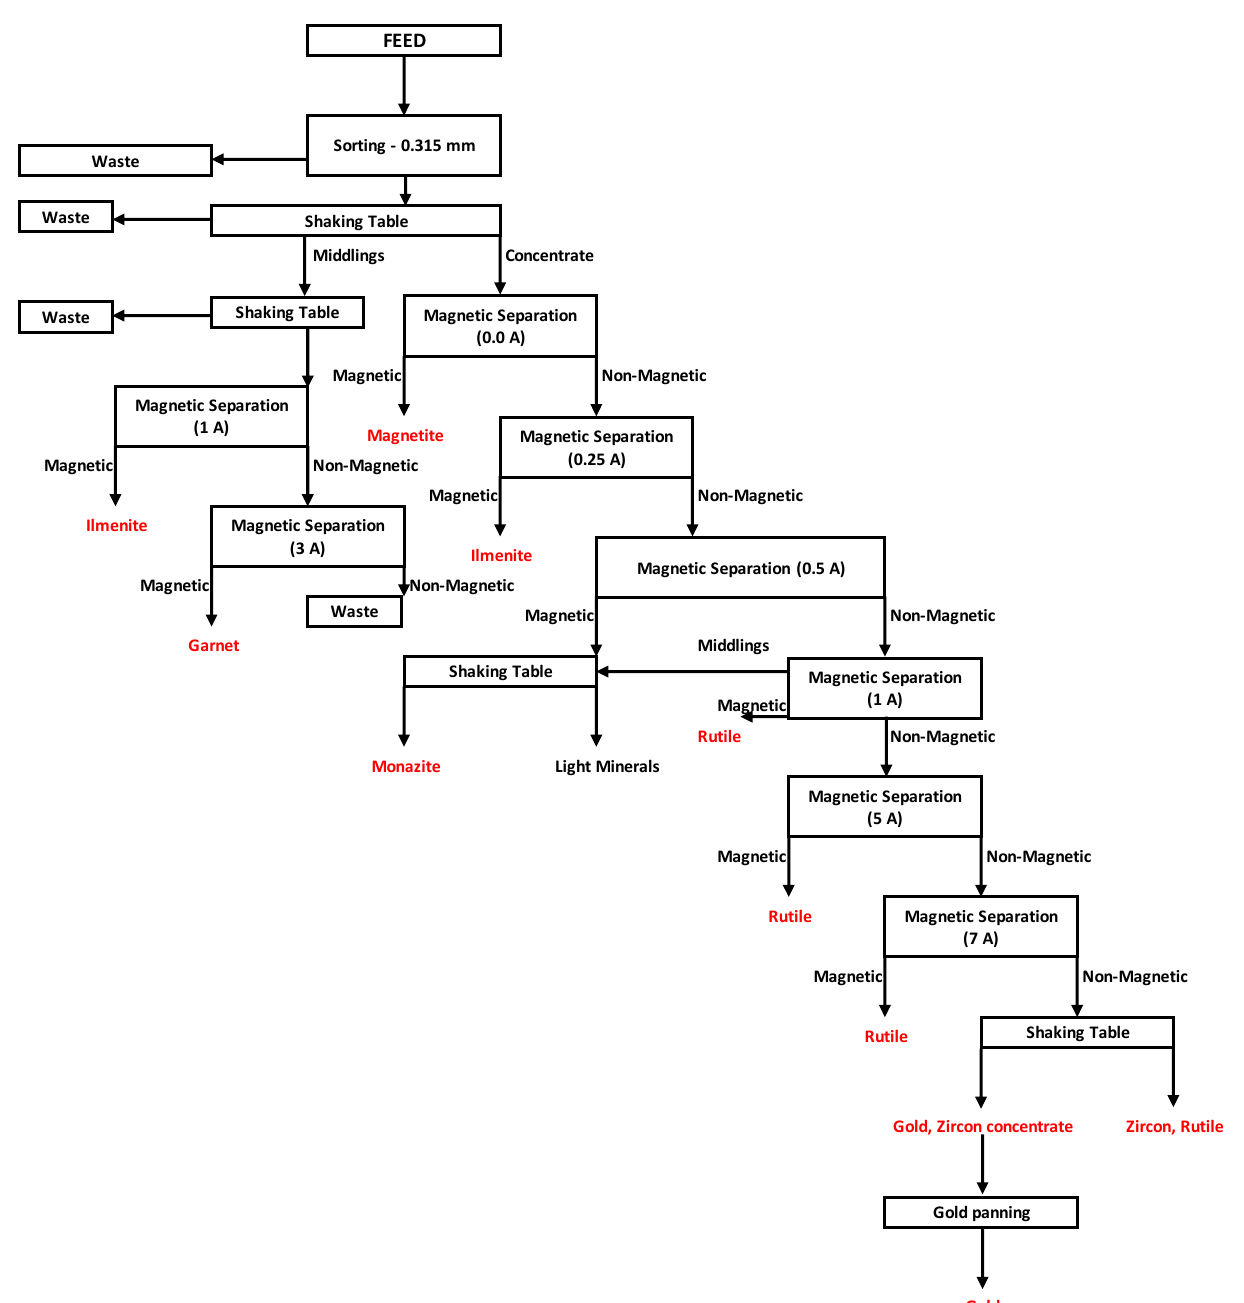
Figure 3. Scheme of processing VHM concentrates from the feed sample.